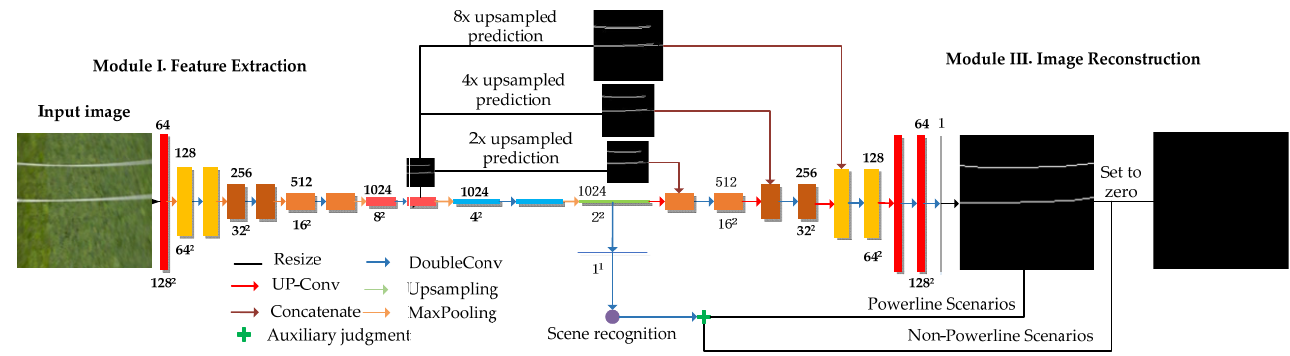
Figure 2. The architecture of the proposed PLE model. Each colored box corresponds to a multi- channel feature map. The number of channels is denoted on top of the colored box. The x-y size is listed at the bottom of the colored box. Box without numbers means it has the same channel and size with the same colored box. The colored arrows and lines denote the different operations.